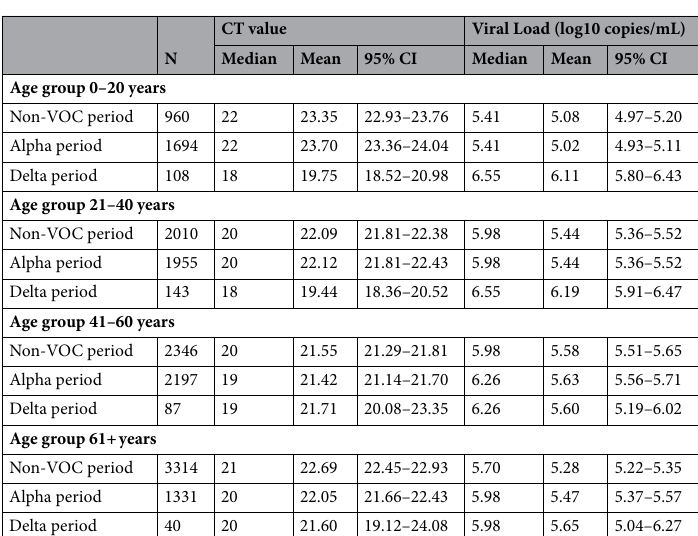
Table 2. Comparison of CT values and viral loads between non-VOC, Alpha and Delta variants of SARS- CoV-2 per age group.